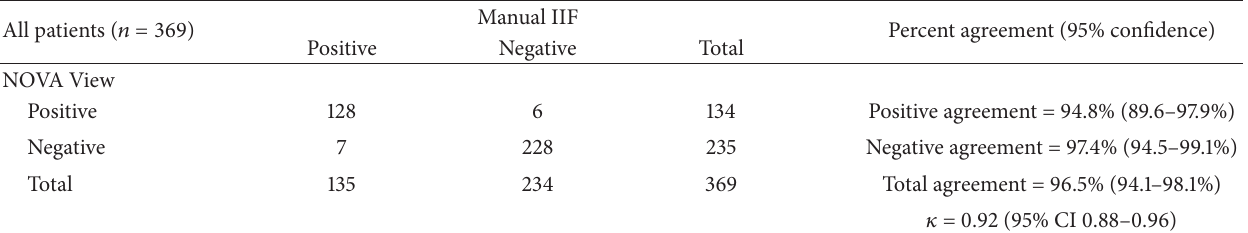
Table 1: NOVA View agreement with manual IIF: 1: 40 screening dilution.